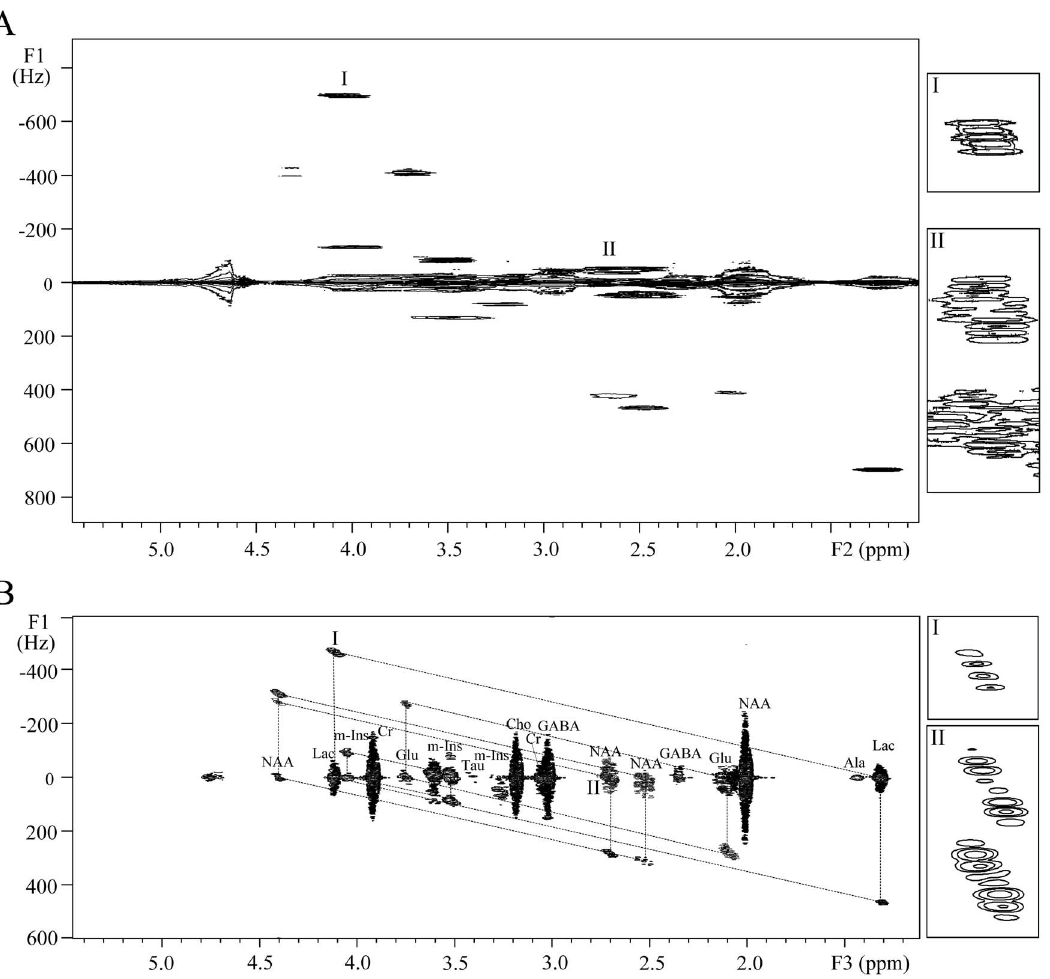
Figure 5. SECSY spectra of an aqueous solution of brain metabolites. (A) Conventional spectrum in an inhomogeneous field with a line- width of 200 Hz; (B) DDF-SECSY spectrum using ultrafast acquisition scheme. The marked regions are expanded for comparison.